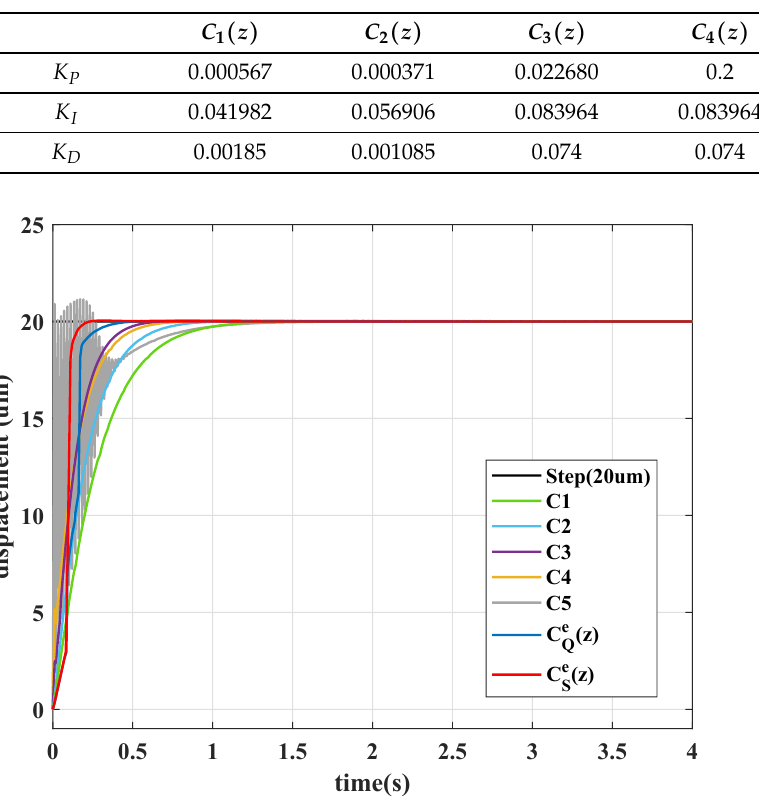
Table 4. Controller gains of the constant PID controllers.